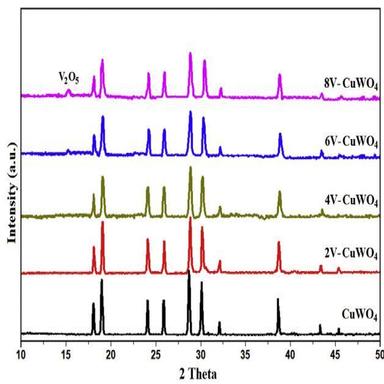
XRD patterns of the prepared CuWO4 and V doped CuWO4 materials.